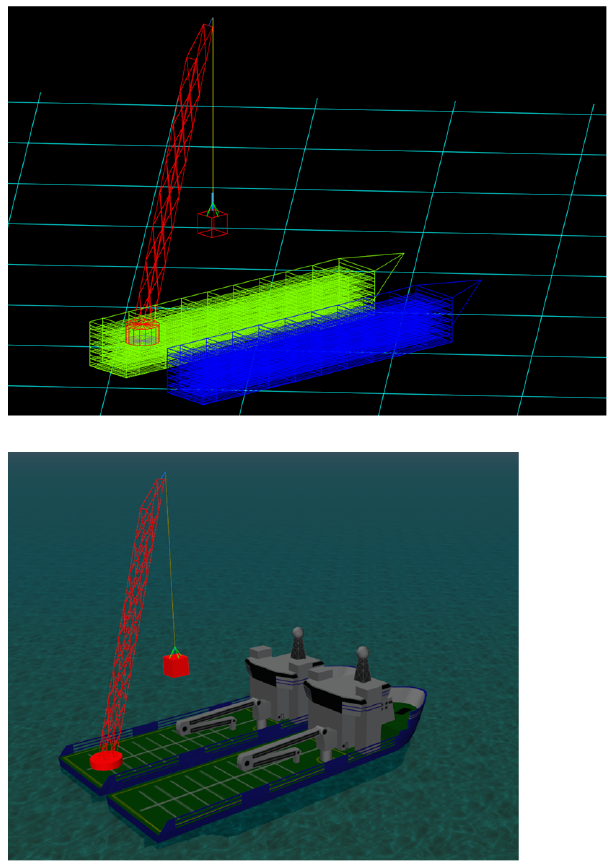
Figure 6. The schematic model of full-circle swing hoisting operation.